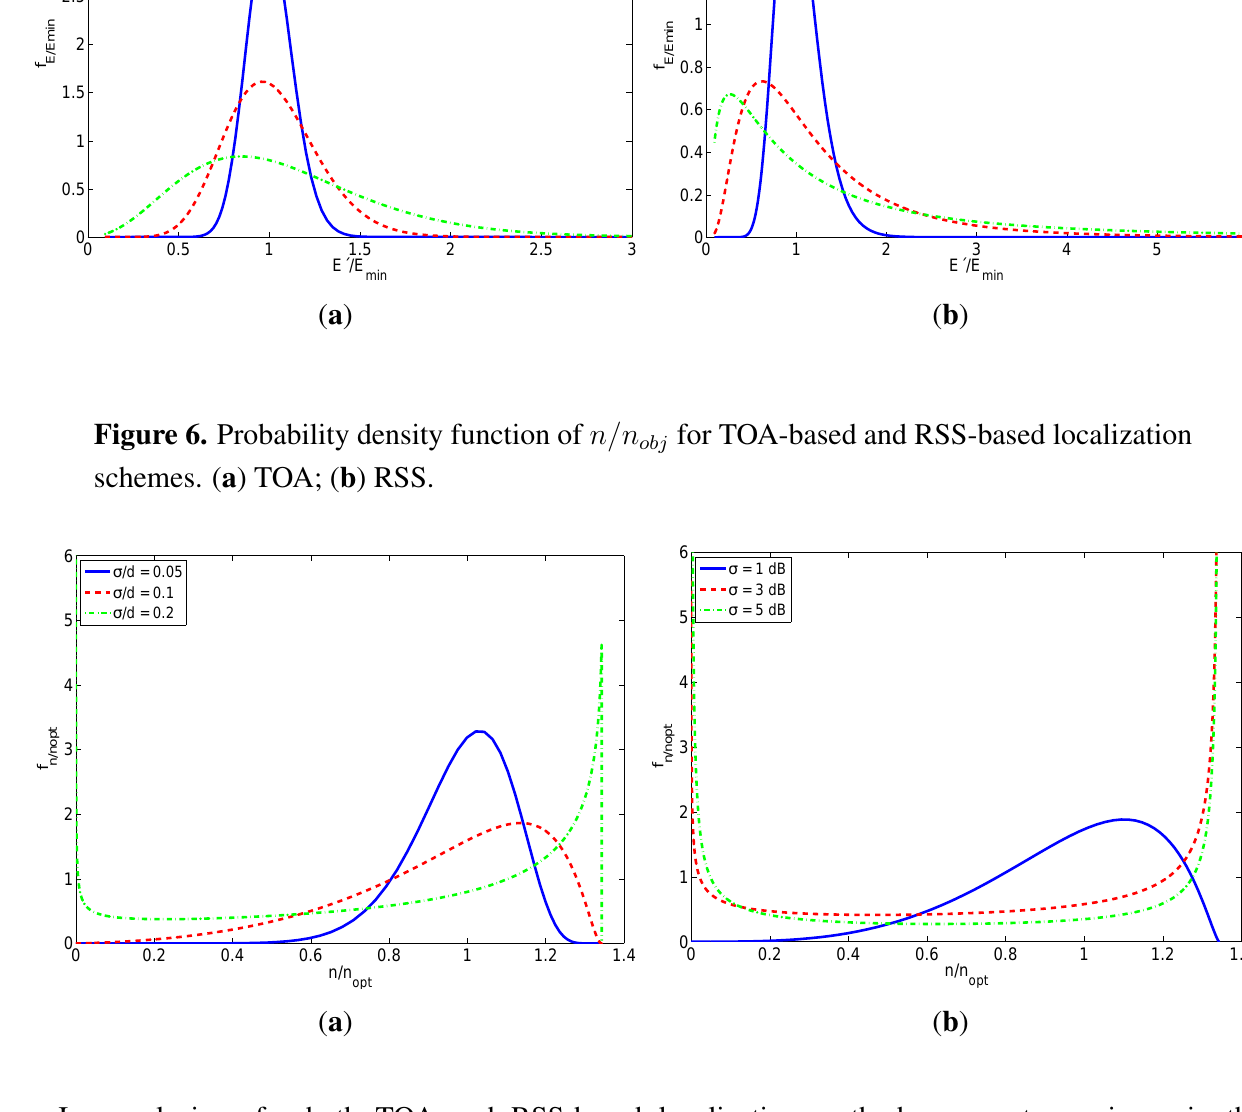
Figure 5. Probability density function of E (cid:48) /E localization schemes. ( a ) TOA; ( b ) RSS.